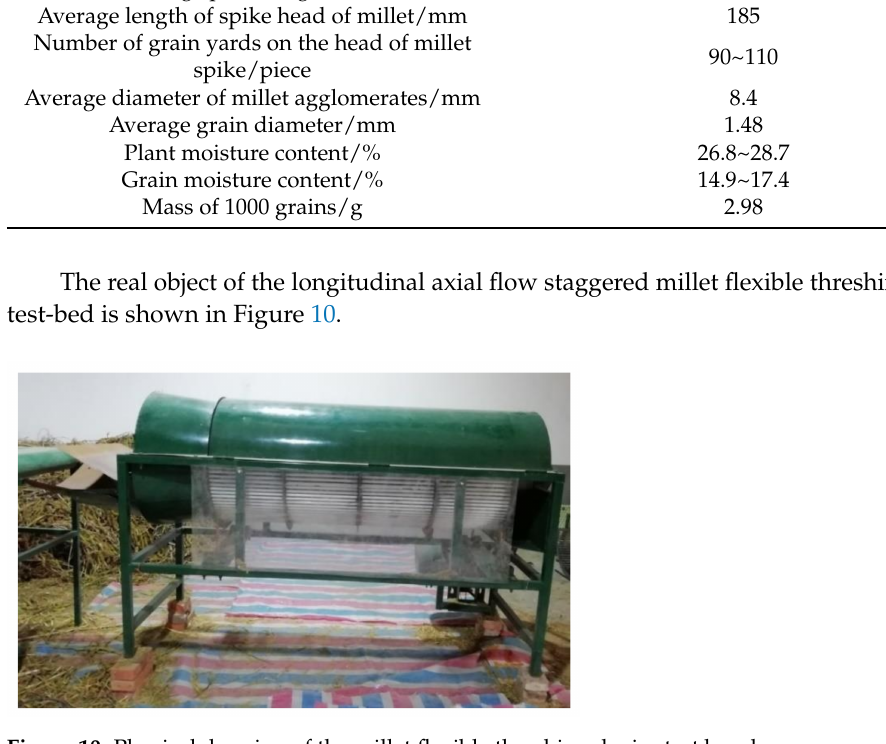
Figure 10. Physical drawing of the millet flexible threshing device test